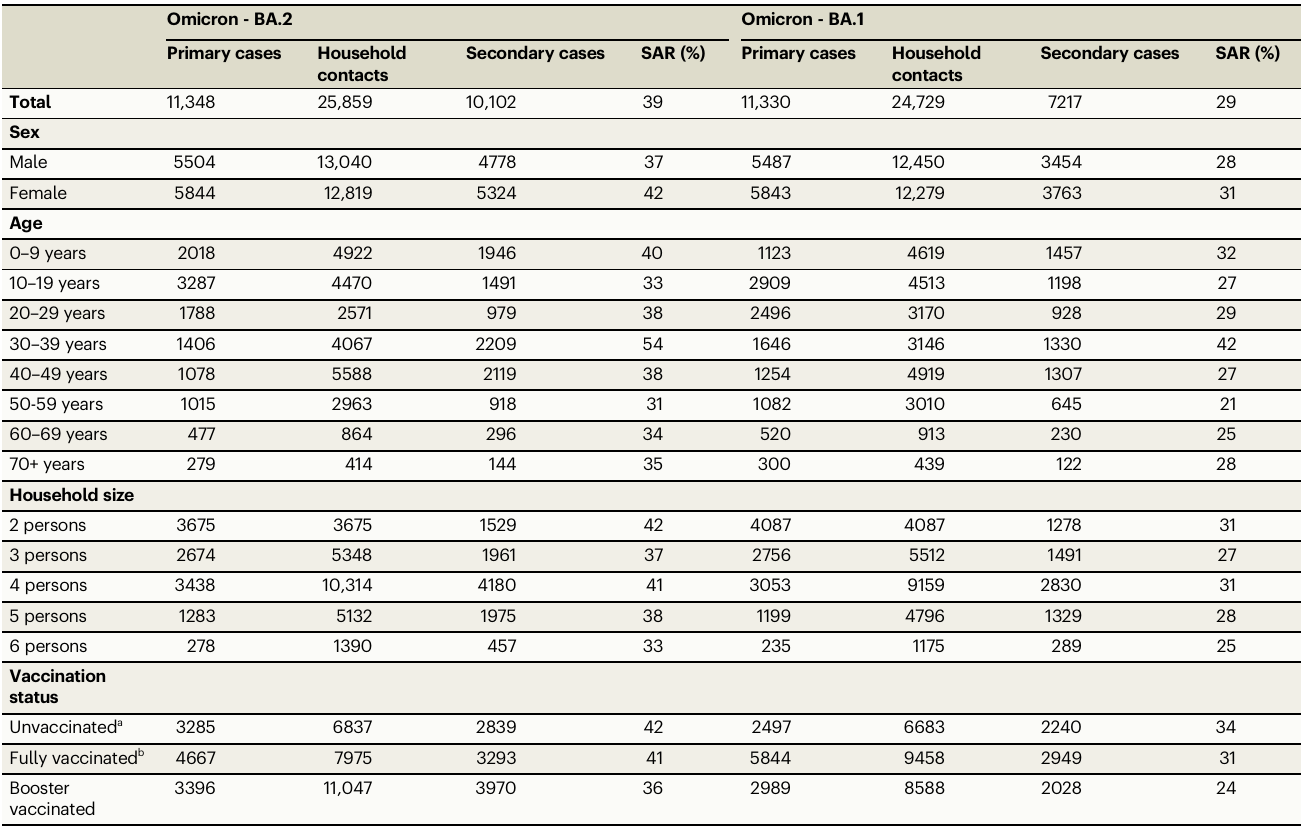
Table 1 | Summary Statistics (primary cases and contacts reported separately) Omicron -